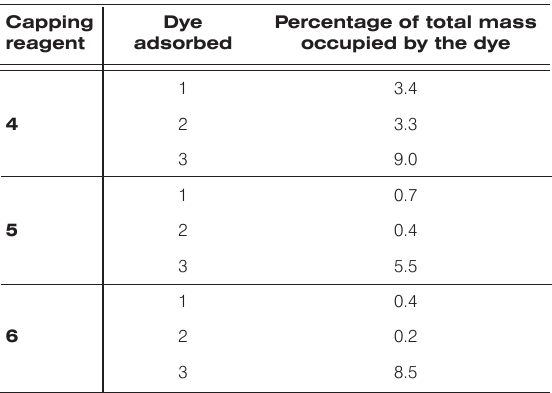
Table 1. The amounts of dyes adsorbed on functionalized silicas prepared. Capping Dye reagent adsorbed